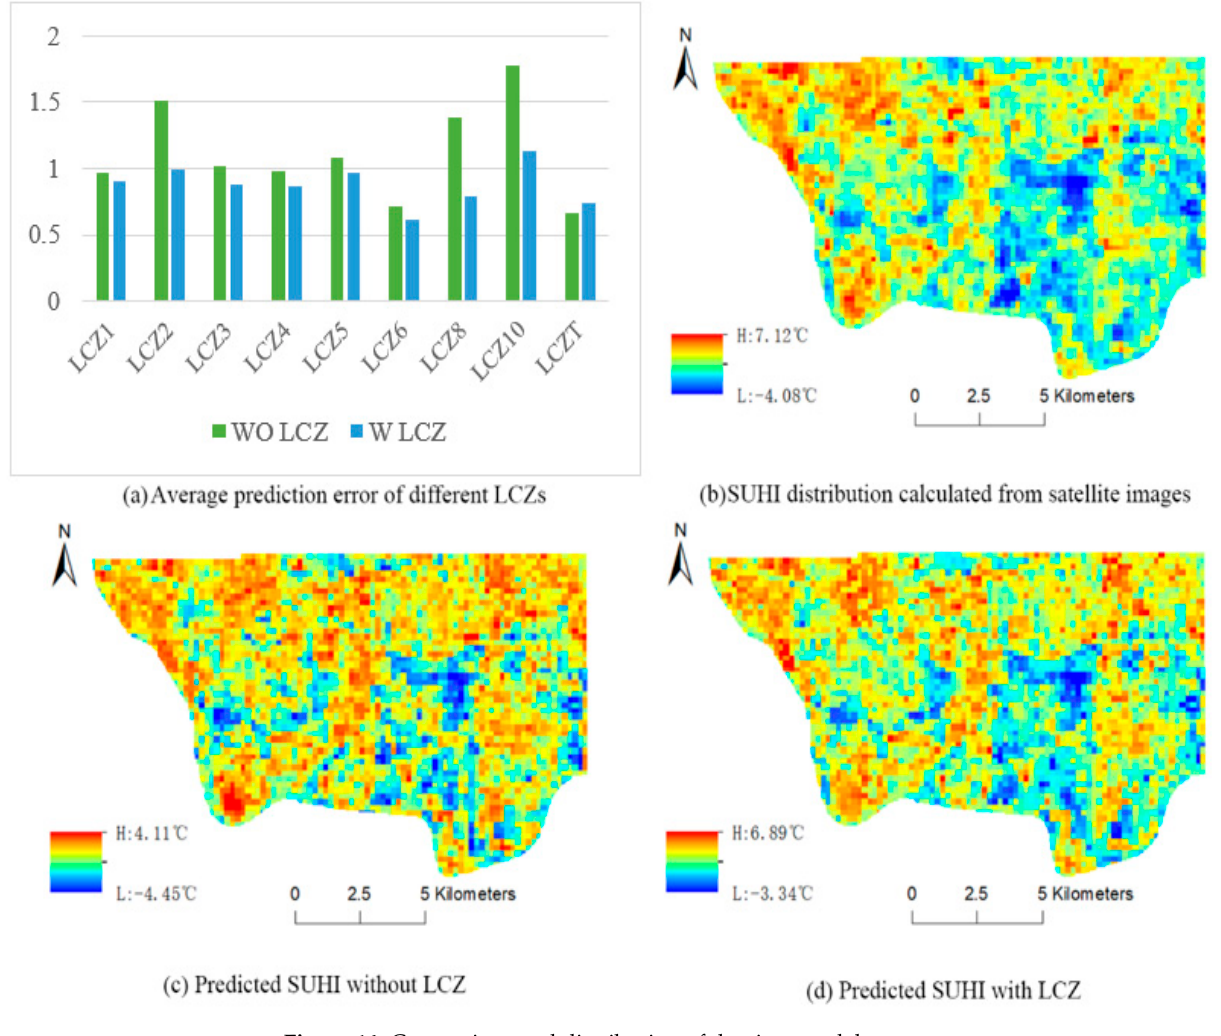
Figure 14. Comparison and distribution of daytime model errors.